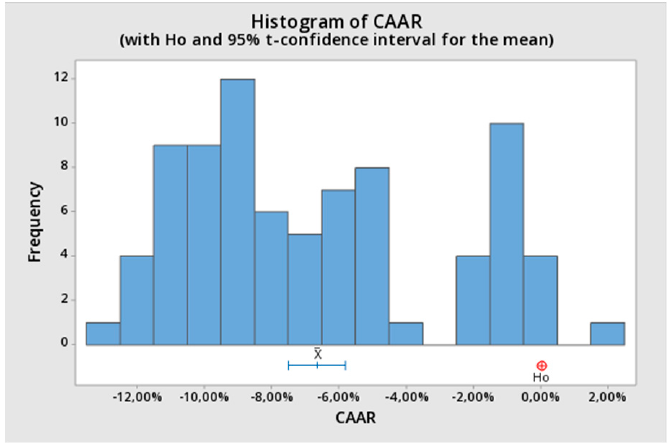
Figure 2. t -Test histogram of CAAR for E ( − 40, +40).